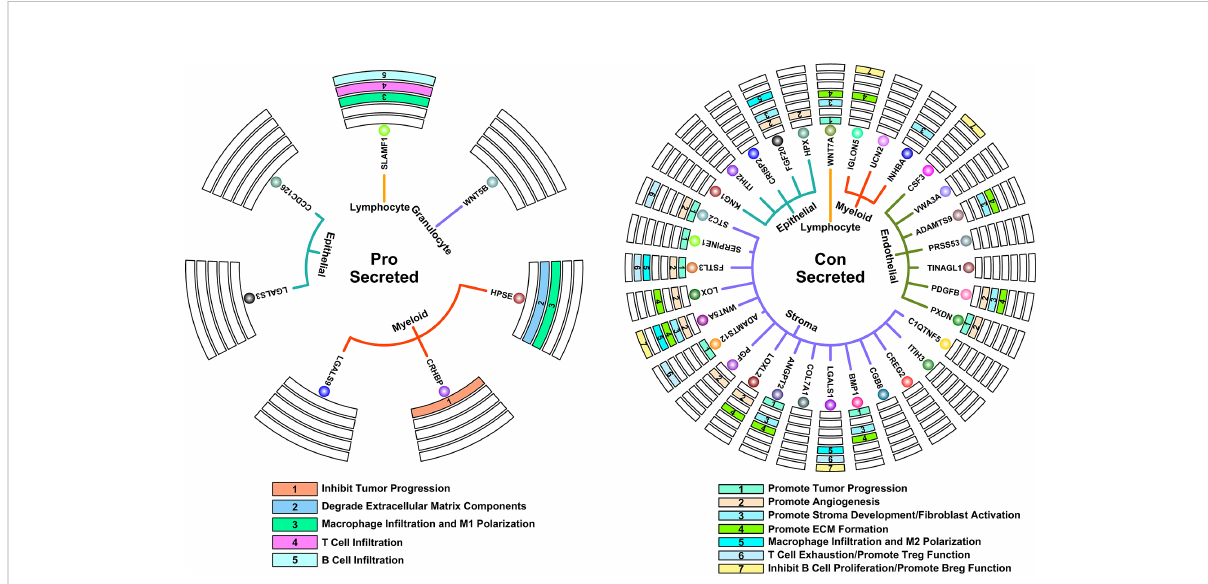
FIGURE 7 Key regulatory interactions in controlling 5-FU responses. Circle map representing secreted proteins that could contribute to 5-FU-bene fi t response (left); Circle map representing secreted proteins that could contribute to 5-FU-futile response